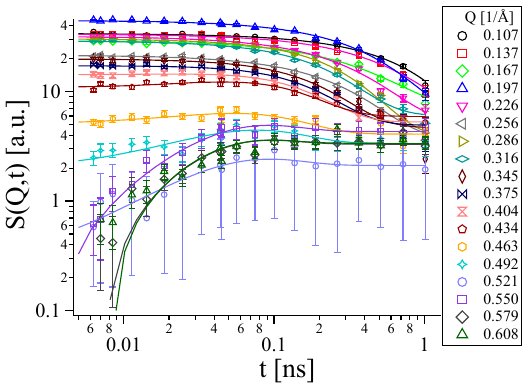
Figure 3. NSE data and fit for octanol in the B2 mixture d- ethanol / h-octanol (0.61 mol of ethanol), according to eq. 3 for the di ff erent values of Q . Data are measured on the spectrometer IN11 at the ILL (France).